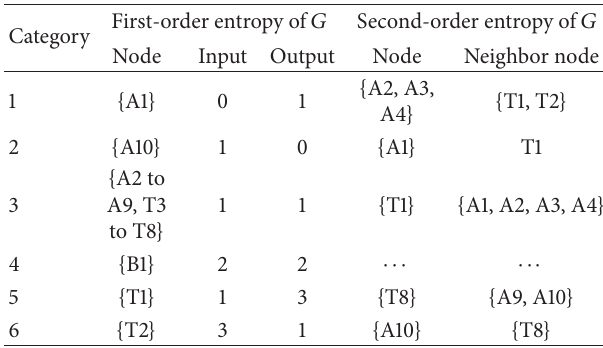
Table 2: Classification on the first- and the second-order entropy of process control